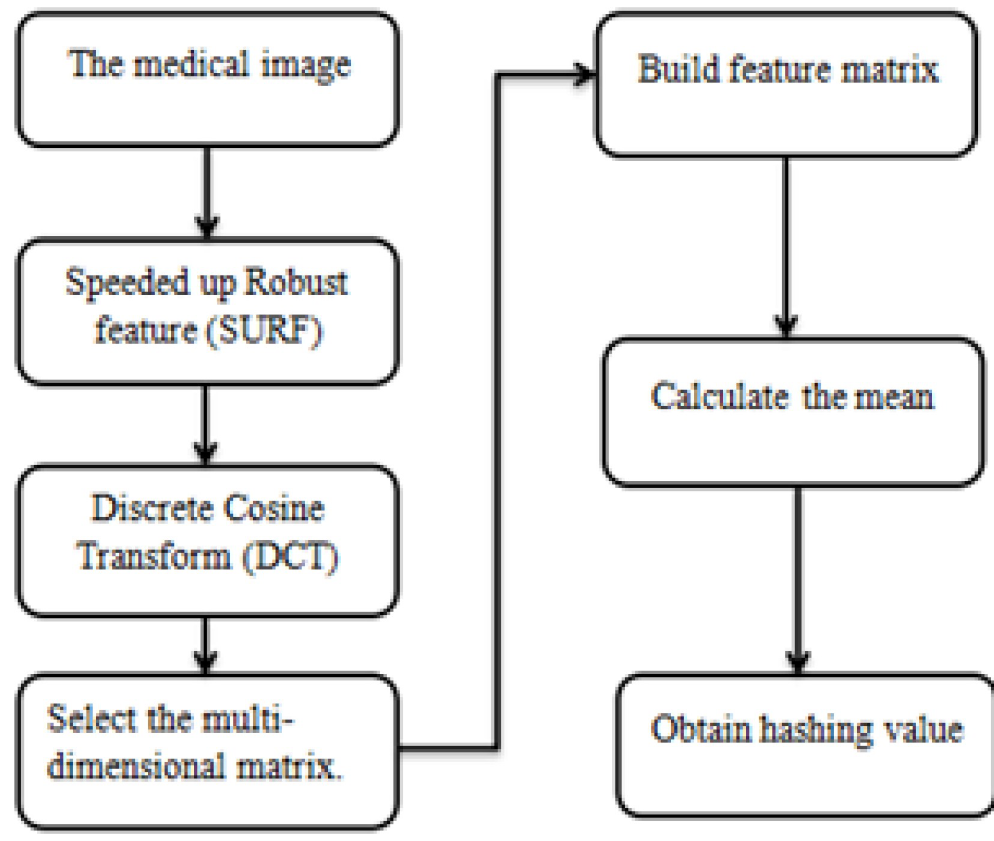
Fig 5. SURF for feature selection.